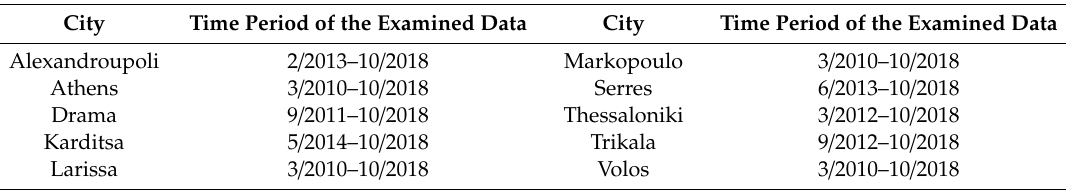
Table 1. Time period referred to in each time-series dataset for all cities.